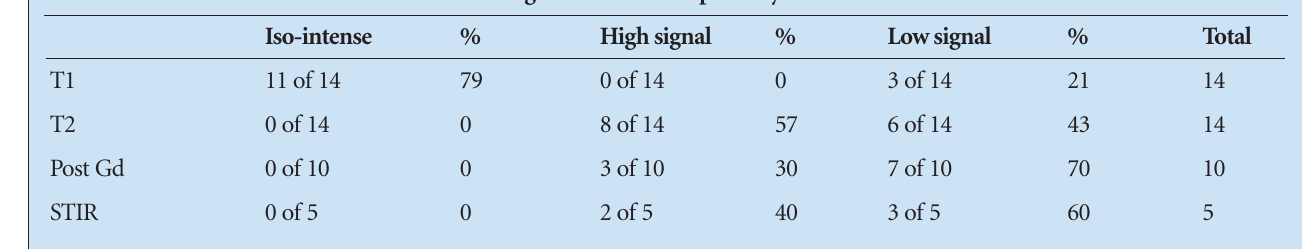
Table V. Signal intensities in partially affected